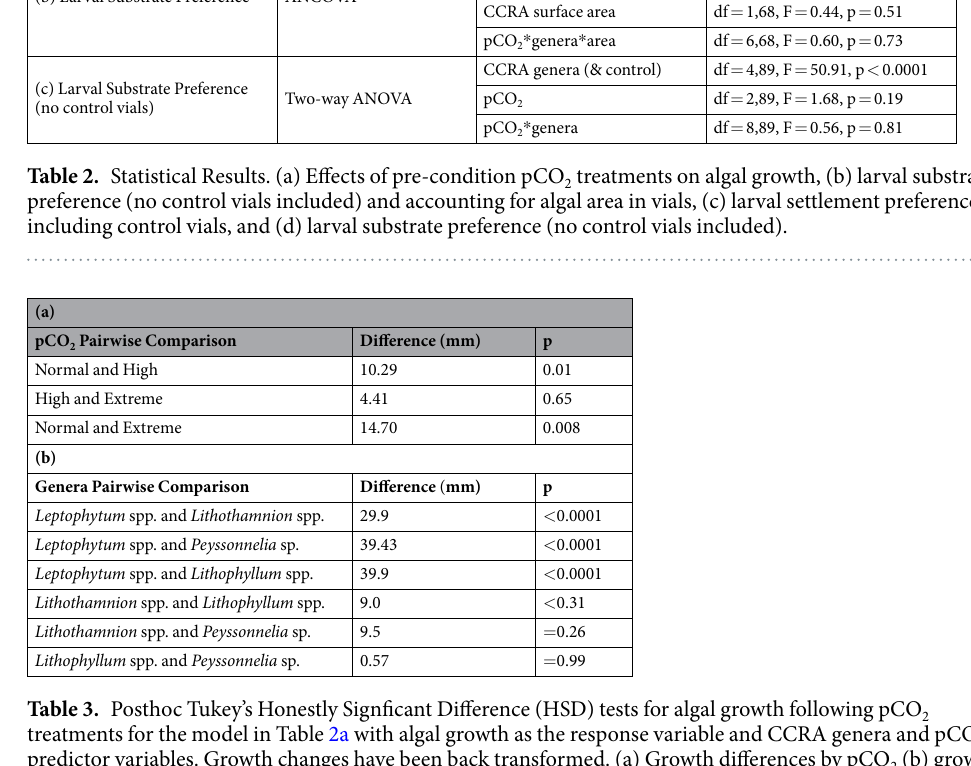
variation in CCRA surface area in vials, which ranged from 147 to 405 mm 2 (Table 2b). Treatments that had no CCRA (control vials) had only 11% settlement compared to 48–69% in vials with CCRA (Table 2c and Fig. 3). There were significant differences in settlement rates between the four CCRA genera (p < 0.0001, Table 2c and Fig. 3): two genera, Lithothamnion spp. and Leptophytum spp., had higher settlement with 62 and 69% of larvae settling respectively while the other two genera, Lithophyllum spp. and Peyssonnelia sp, each had 48% of larvae